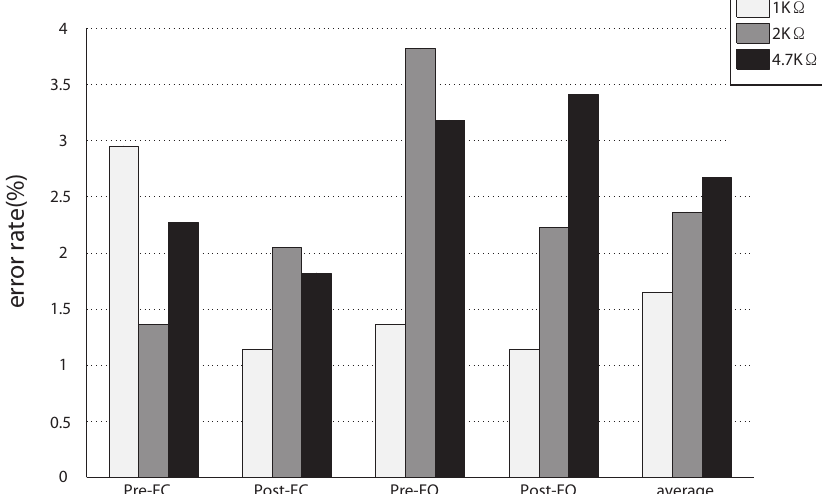
Figure 7. Classification errors of different levels of resolution. The right bars show the average recognition errors over four gait phases. The results were obtained with linear discriminant analysis (LDA) classifier and 200 ms phase